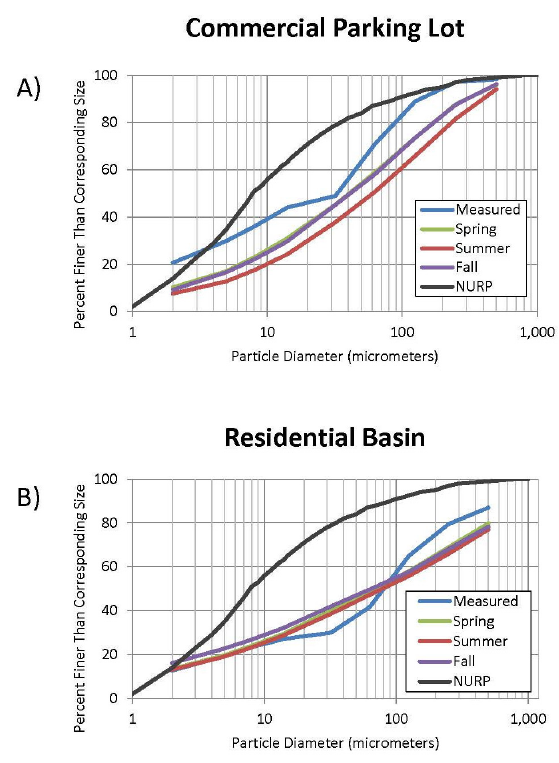
Figure 4. Measured and seasonal median particle size distributions in the commercial parking lot ( A ) and residential basin ( B ) study areas compared to NURP. Table 2. Particle diameter associated with varying levels of solids reduction. All values, with the exception of percent control, are expressed in terms of micrometers. Values were calculated by linear interpolation from particle size distributions (PSDs) in Figure 4A,B (rounding was applied).